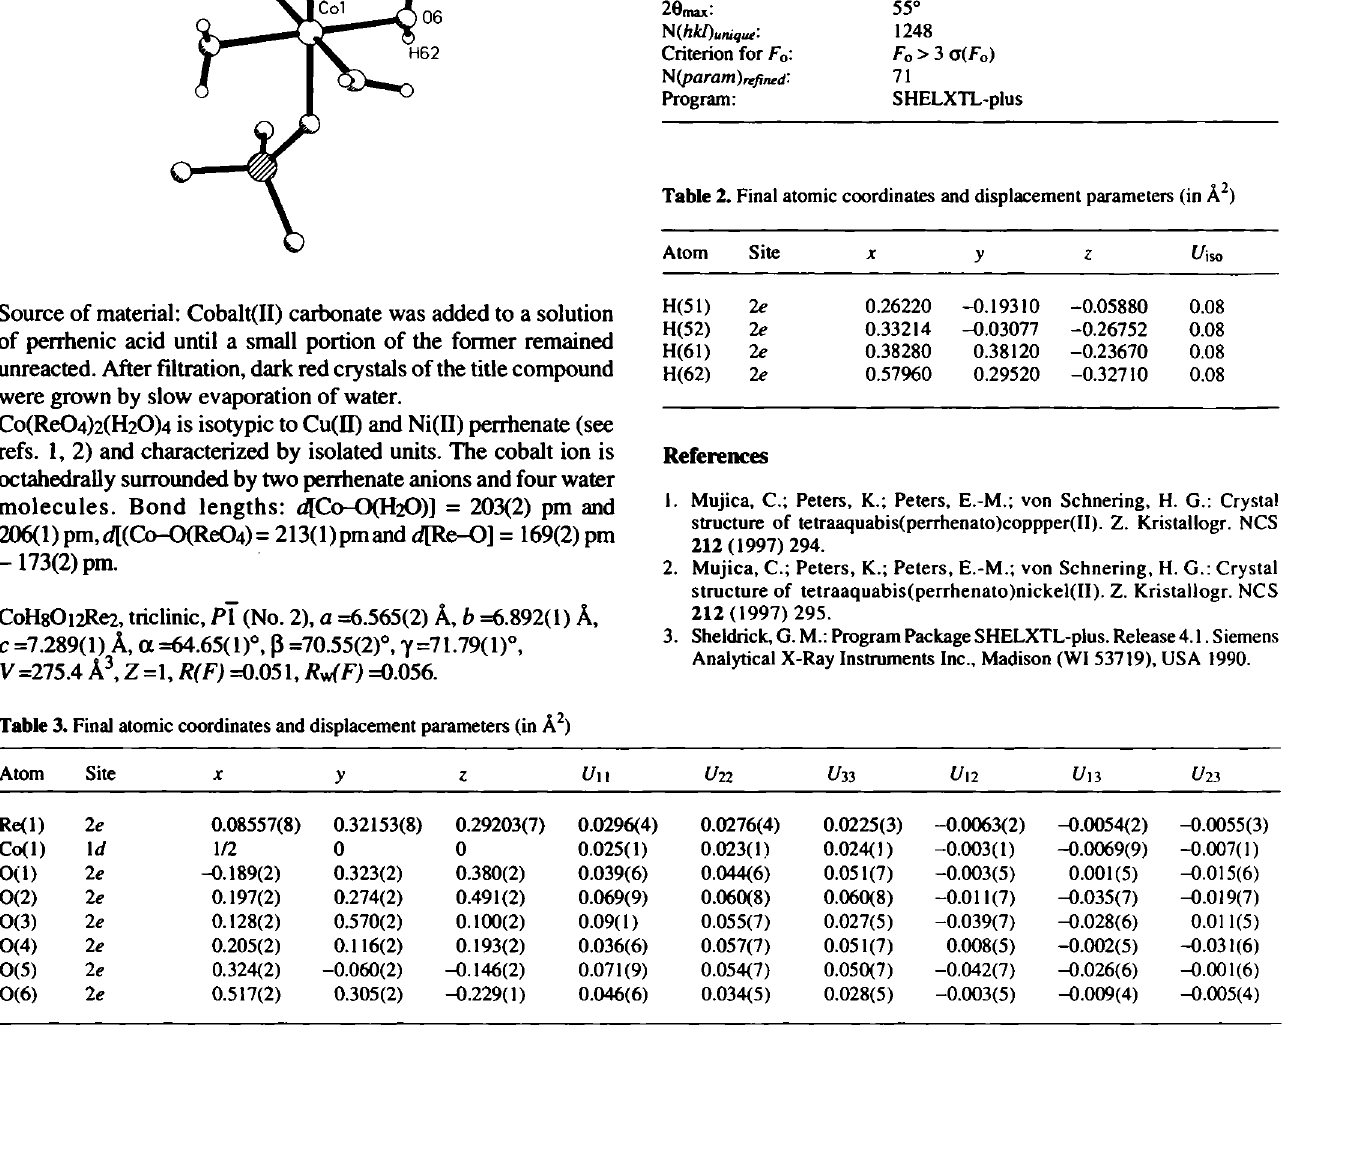
Table 2. Final atomic coordinates and displacement parameters (in